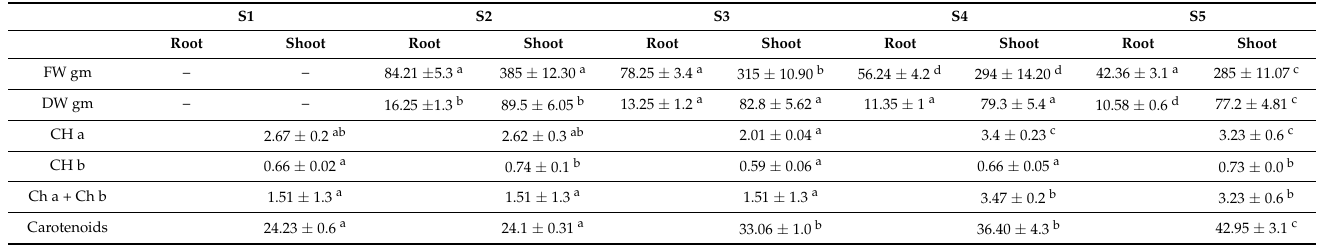
Table 5. Fresh weights, dry weights and growth pigments of S. portulacastrum grown in different control sites (Site 1) and contaminated sites (Site 2–5). Data are mean values ± SE ( n = 4). Different letters (a–d) represent the significant differences between the effect of heavy metal stress in the different target sites (Tukey test ( p < 0.05)). S2 S3 S4